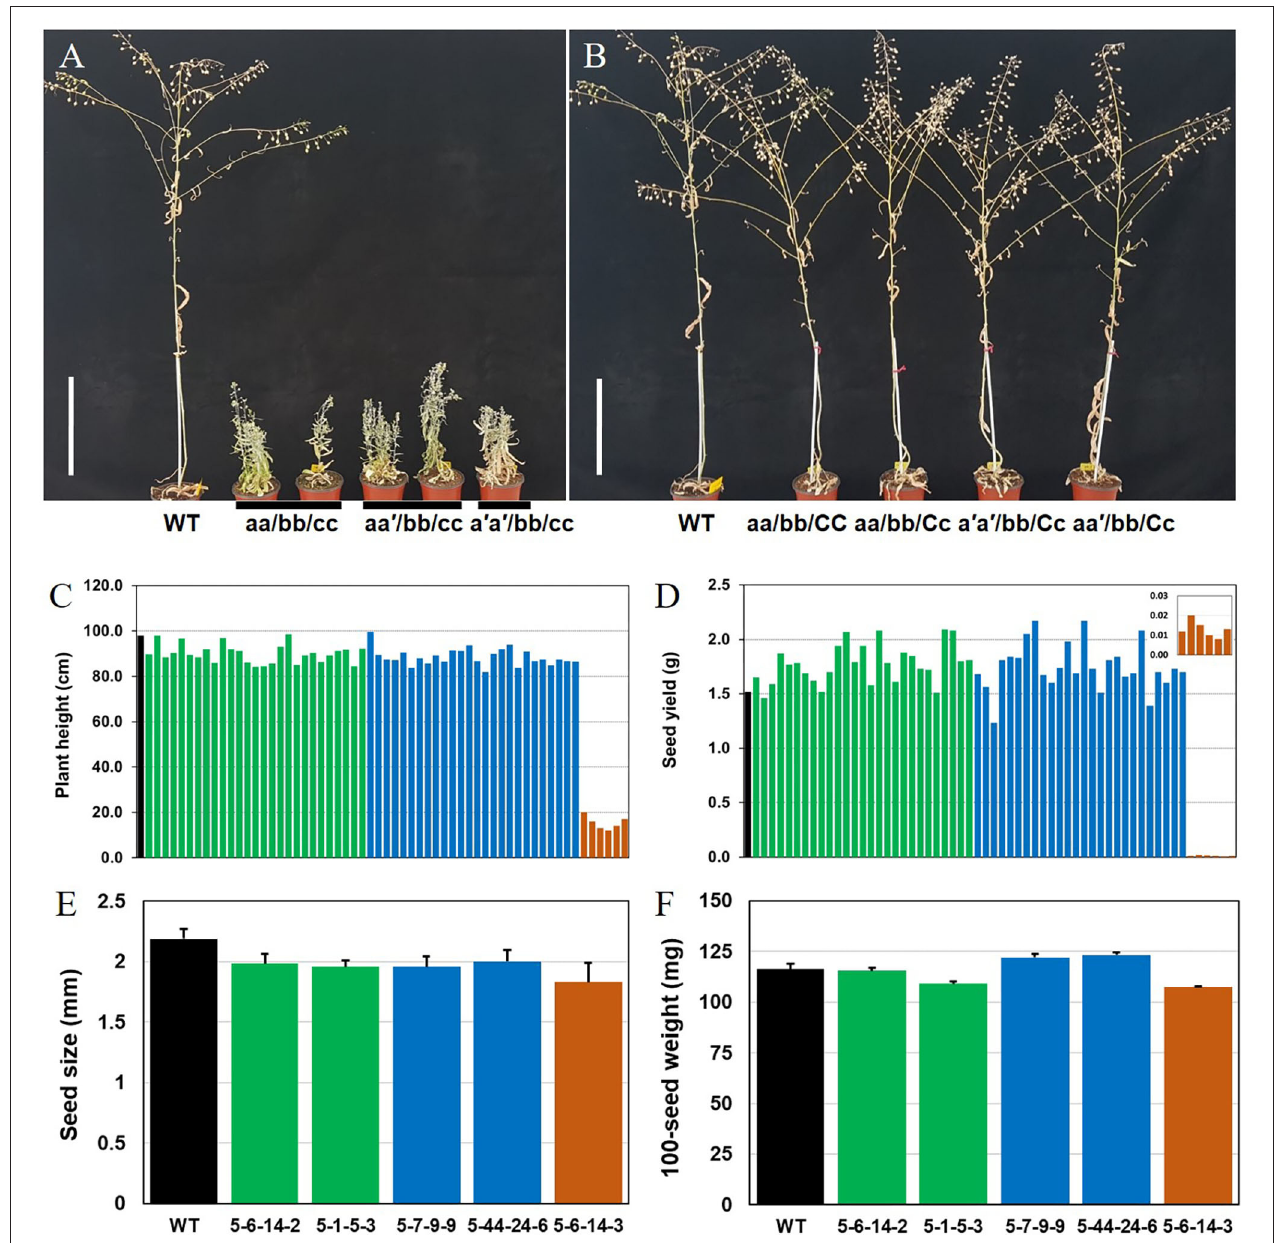
FIGURE 4 | Different Camelina CsFAD2 KO genotypes result in varying phenotypes at 3 months. (A) Three types of Camelina plants with complete CsFAD2 KO showing a stunted bushy phenotype. (B) Camelina plants with incomplete CsFAD2 KO and more than one normal CsFAD2 homoeolog show normal growth. (A–C) indicate the CsFAD2-1 to CsFAD2-3 homoeologs, respectively. Lowercase letters with and without an apostrophe ( ′ ) indicate missense and non-sense mutants of CsFAD2 homoeologs, respectively. Vertical bar = 20cm. (C) Plant height (from the ground) of CsFAD2 KO Camelina. (D) Seed yield (total seed weight) of CsFAD2 KO Camelina. The line numbers of green, blue and brown bar in both (C,D) are in order as follows. Green bar, EC#5-44-24-3 (EC# is omitted hereafter), 5-7-9-5, 5-6-24-5, 5-6-14-6, 5-6-24-2, 5-26-10-6, 5-6-24-9, 5-26-10-7, 5-6-24-8, 5-6-24-3, 5-26-10-4, 5-7-9-7, 5-44-24-5, 5-44-24-4, 5-44-24-10, 5-7-9-6, 5-26-10-3, 5-6-24-4, 5-6-24-10, 5-1-5-8, 5-1-5-2, 5-7-9-4, 5-1-5-3, 5-6-14-2, 5-6-14-8, 5-44-24-1, and 5-26-10-10; blue bar, 5-6-14-7, 5-26-10-5, 5-6-24-6, 5-26-10-8, 5-6-14-5, 5-1-5-6, 5-7-9-10, 5-7-9-9, 5-6-24-1, 5-44-24-7, 5-6-14-10, 5-6-14-9, 5-44-24-6, 5-7-9-8, 5-7-9-1, 5-26-10-2, 5-7-9-3, 5-1-5-4, 5-44-24-9, and 5-26-10-9; brown bar, 5-1-5-5, 5-1-5-9, 5-1-5-1, 5-1-5-7, 5-6-24-7, and 5-44-24-8. (E) Seed size of CsFAD2 KO Camelina ( n = 10, Mean ± SD). (F) 100-seed weight of CsFAD2 KO Camelina ( n = 3, Mean ± SD). From (C) to (F) , black, green, blue, and brown bars represent WT, aa/bb/CC, aa/bb/Cc, and aa/bb/cc, respectively. CsFAD2 triple mutants increased 1.3-fold (27.3% from 20.8% in of the CsFAD2 triple mutants increased 6.5-fold, i.e., 24.5% the WT), whereas the 16:3 content decreased (9.3 vs. 12.5% in the compared to 3.8% in the WT, whereas the 18:3 content decreased WT). We also examined MUFA and PUFA contents in the to almost half (26% from 47.5% in the WT). The 16:0 content of